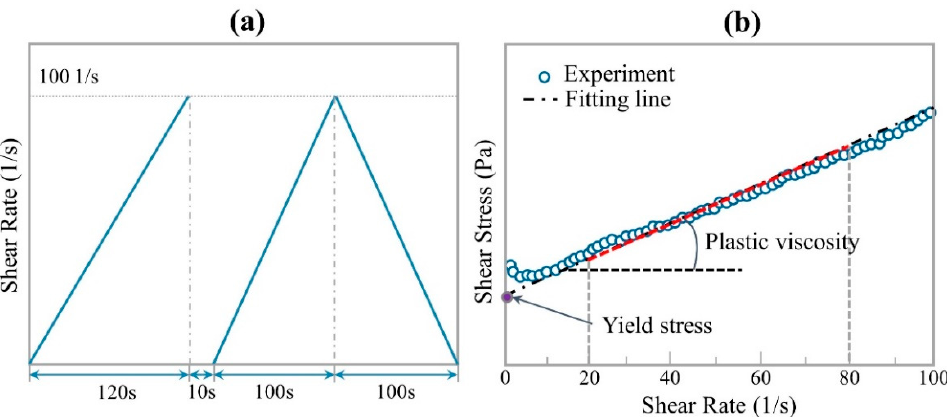
Figure 2. ( a ) Test procedure of rheological parameters; ( b ) the yield stress and plastic viscosity obtained by the Bingham model. obtained by the Bingham